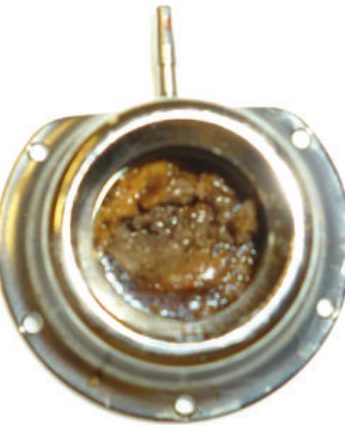
Figure 2: Build-up of deposits of fibrin and/or infusion fluids and/or drug